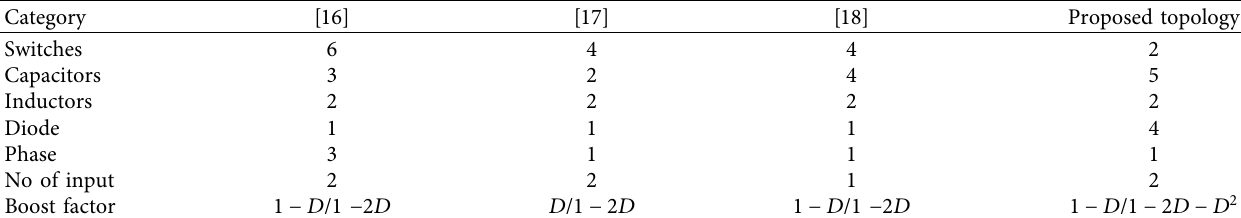
Table 2: Comparison